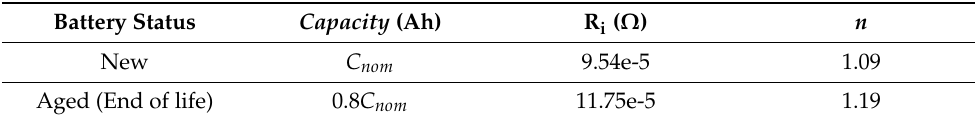
Table 5. Values assumed for the battery